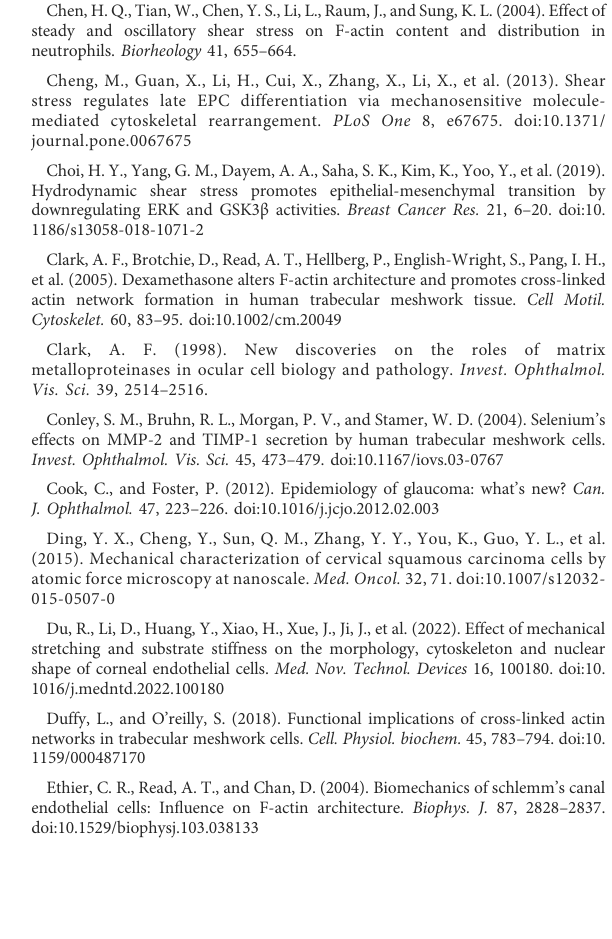
SUPPLEMENTARY FIGURE S1 Morphology and myocilin (MYOC) gene expression of PTM cells. (A) Image of primary PTM cells. (B) Image of passage PTM cells. (C) Staining for fi bronectin (FN) and laminin (LN) of PTM cells. (D,E) Myocilin gene expression in PTM cells after corticosteroid treatment. There was a substantial increase in myocilin expression after dexamethasone (DEX) treatment (*** p <